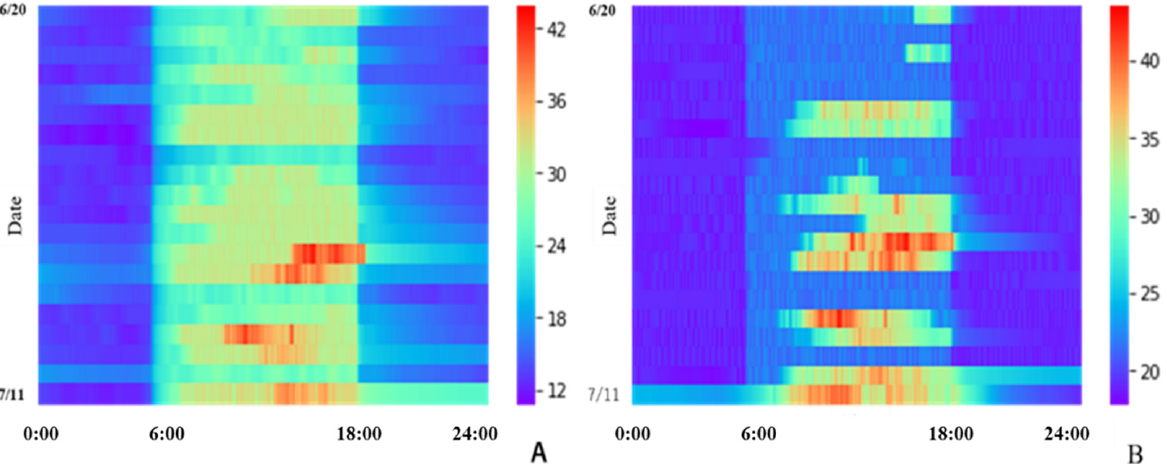
Figure 1. Temperature variations in ( A ) low (LT, 35/10 ± 2 °C, day/night) and ( B ) high (HT, 25/20 ± 2 °C, day/night) night temperature (NT) treatments.